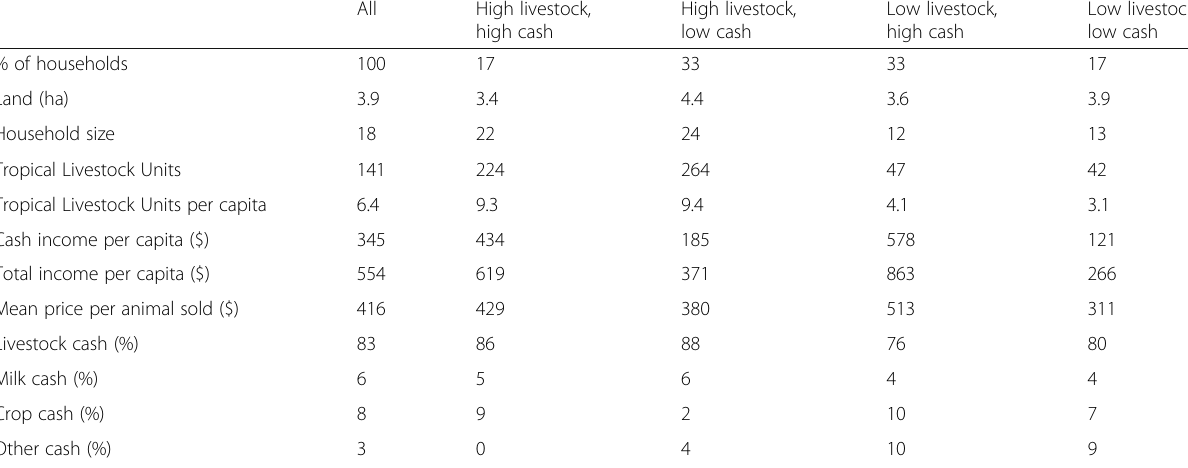
Table 5 Wealth groups, assets and income (based on McPeak, Little and Doss 2012)